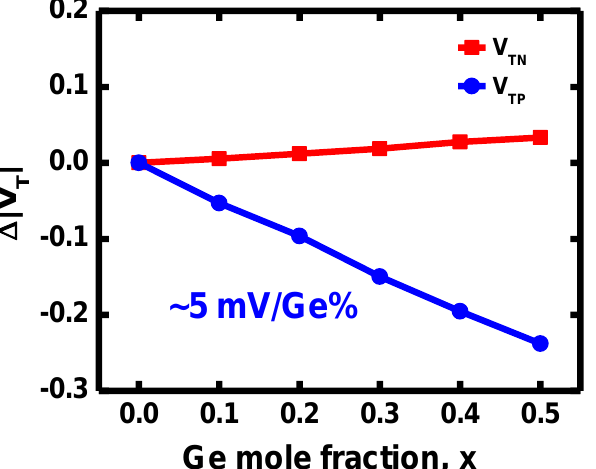
Figure 4. The V T shift of NMOS and PMOS with varying Ge mole fraction, x, where the V T shift is quantified relative to the VT of x = 0.